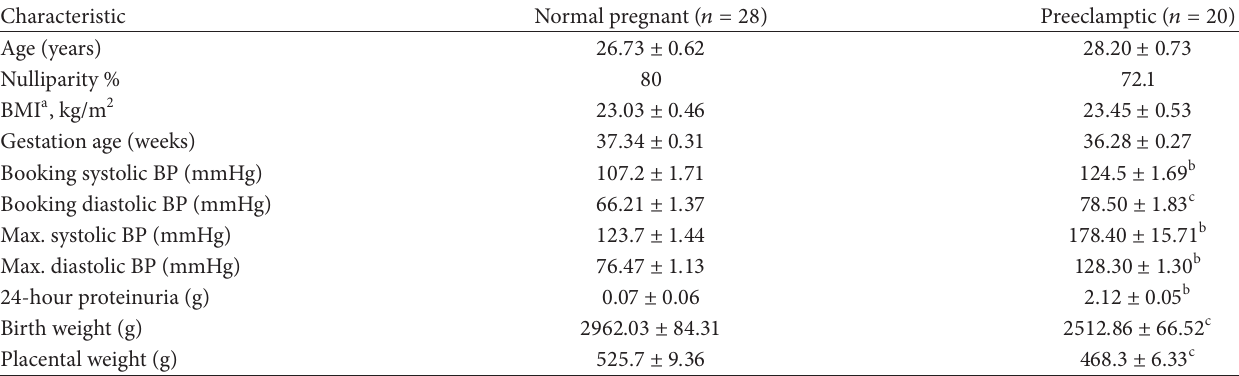
Table 1: Clinical characteristics of the third trimester study between the normal pregnant women and preeclampsia